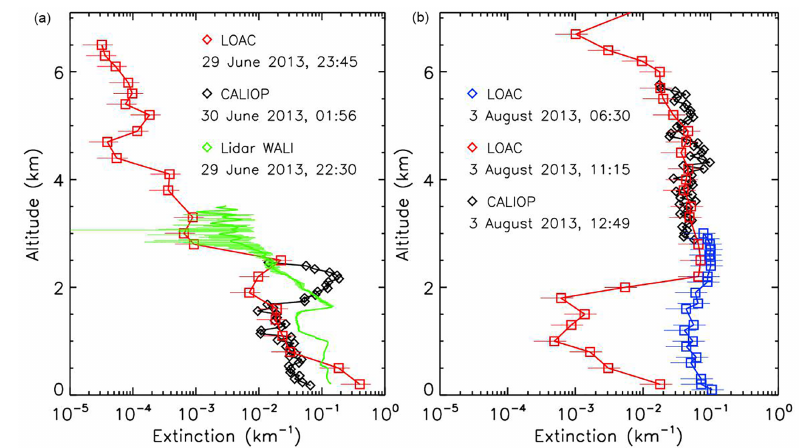
Figure 11. (a) Vertical profiles of aerosol extinction from LOAC, CALIOP, and WALI for the 29–30 June event above Minorca; (b) vertical profiles of aerosol extinction from LOAC (LDB and BLPB flights) and CALIOP for the 3 August event above Ile du Levant.